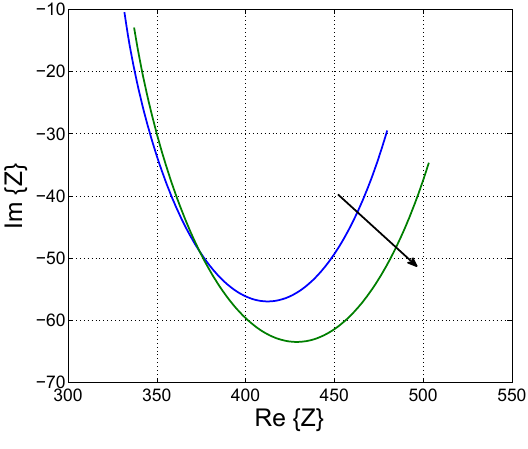
Fig.7: Measured dehydration of the legs R e , rel , as well as the change in R e , AA measured between ankle- to-ankle for all ten athletes. Tab.4: Change of R e and weight for all 10